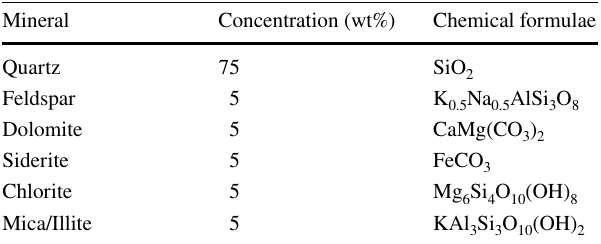
Table 1 Mineralogy of a typical Berea sandstone (Al-Shaalan